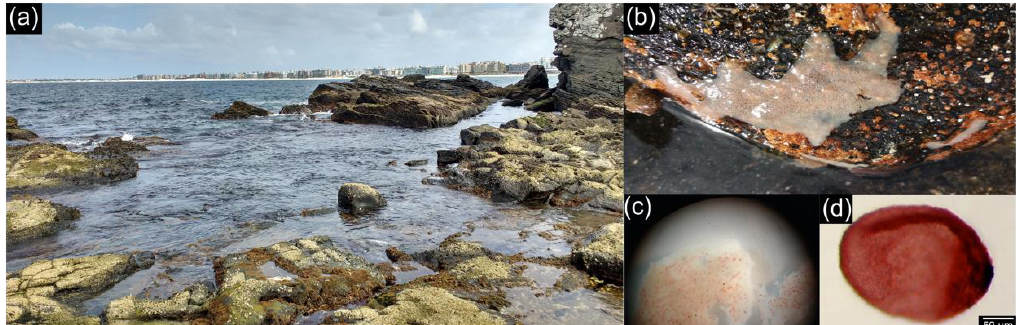
Figure 1. Sampling site and P. cyanorosea adult and larvae: ( a ) “Carolina Tidal Pool” (22°53′13.0′′ S, 042°00′17.9′′ W) under low-tide conditions (30-cm depth). Cabo Frio city can be seen on the horizon in the right-center side of the picture; ( b ) external morphology of P. cyanorosea adult on the under-surface of a small rock collected at the tidal pool; ( c ) closer examination under a dissecting microscope of a P. cyanorosea adult specimen with the larvae concentrated at the sponge base; ( d ) a free-living larvae of P. cyanorosea under a light microscope.